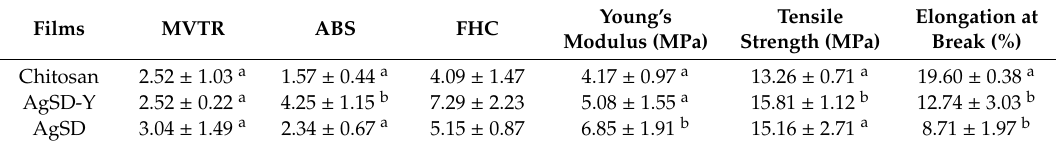
Table 3. Moisture Vapor Transmission Rate (MVTR), Absorbency (ABS), Fluid Handling Capacity (FHC), and mechanical properties of chitosan film, AgSD / Chitosan film and AgSD-Y / Chitosan film (adapted from